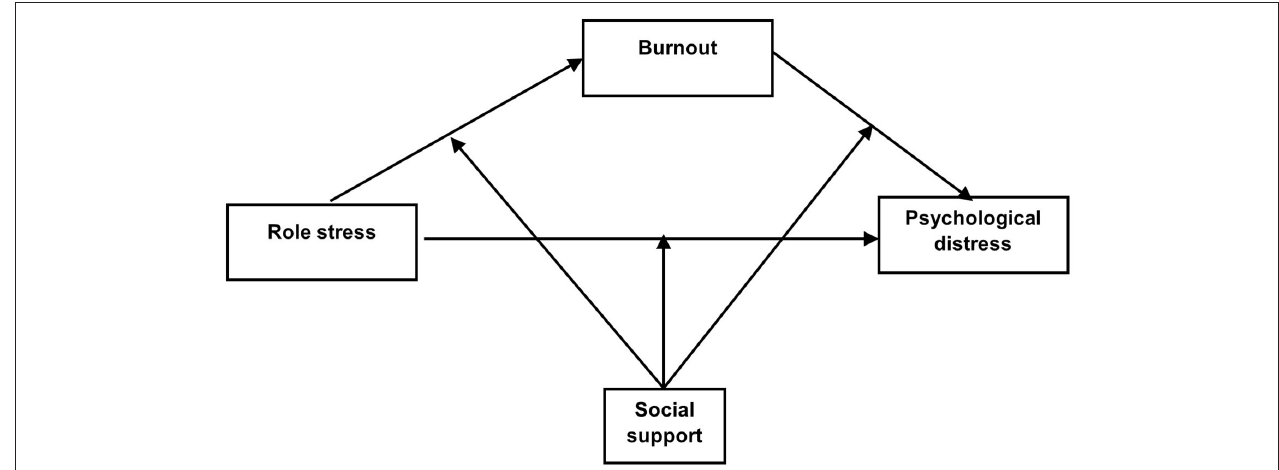
FIGURE 1 | The proposed moderated mediation